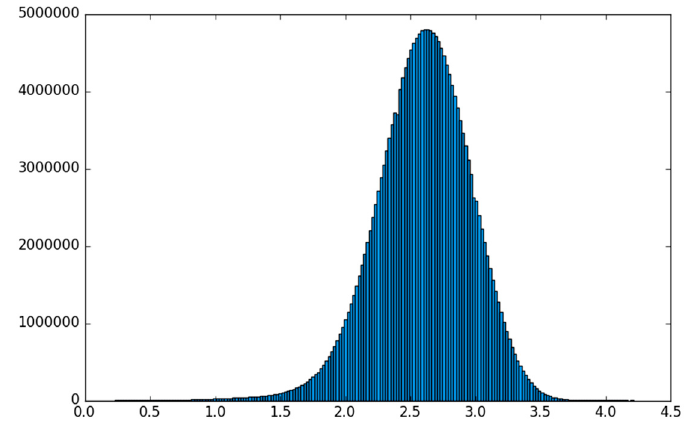
Figure 4. Distribution of sampled points’ pairwise distances from the MNIST dataset.